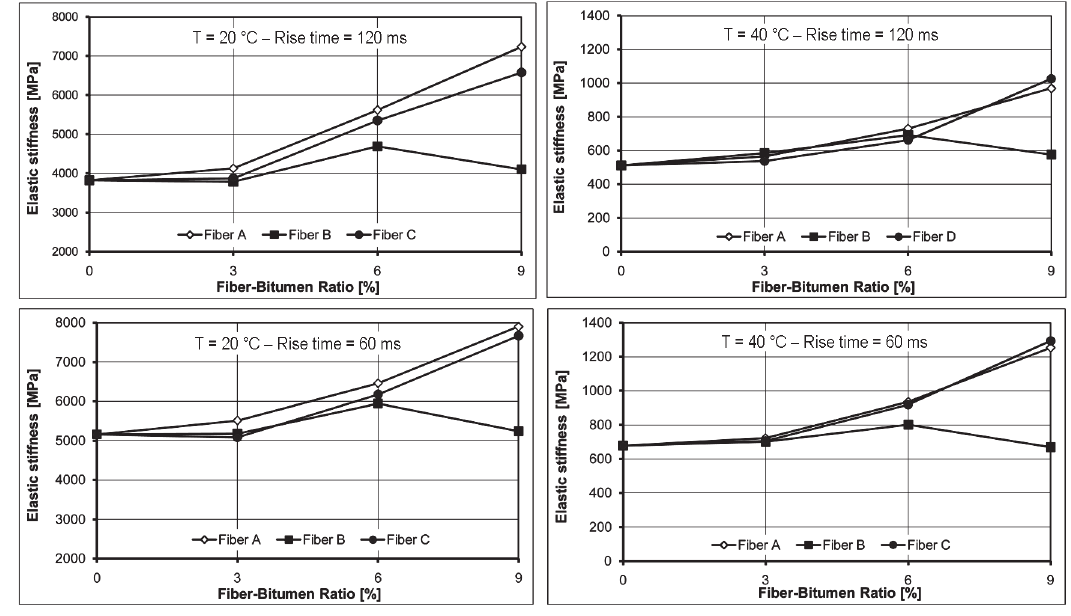
Fig. 10. Elastic stiffness of bituminous mixtures